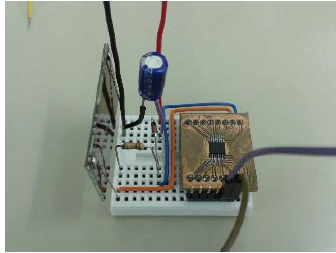
Figure 9. Prototype developed for WuRx design 1.